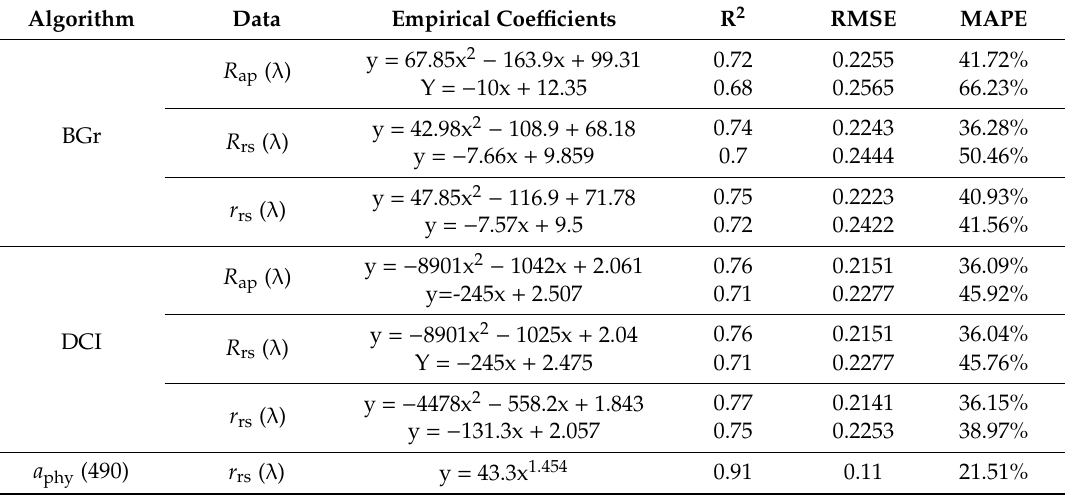
Table 5. The statistics of algorithms in this paper. RMSE, root mean square error; MAPE, mean absolute percentage